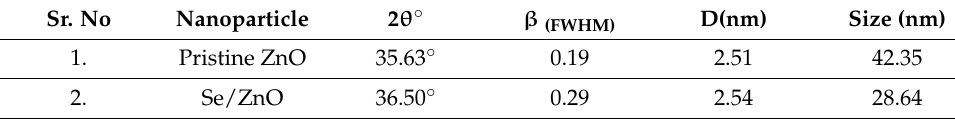
Figure 2. XRD analysis of ZnO NPs and Se/ZnO NPs. Table 1. Crystallite size of pristine ZnO and Se/ZnO.